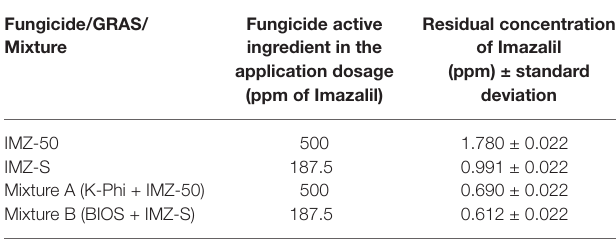
TABLE 2 | Residual concentration of Imazalil in citrus peel from fruits treated with IMZ-50, IMZ-S, Mixture A, and Mixture B. Fungicide/GRAS/ Mixture